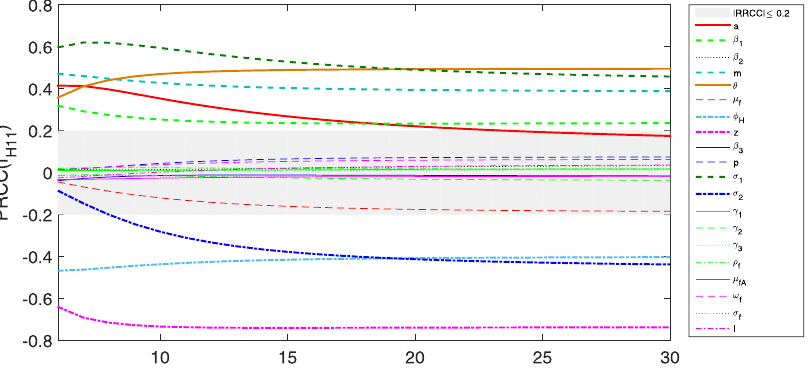
Figure 10. Plot of the PRCC over time of the model (4). The PRCC is calculated with respect to accumulated suspected cases I H 11 . The grey area indicates the region where the PRCC is not significantly different from zero (significance level 0.2), using 2000